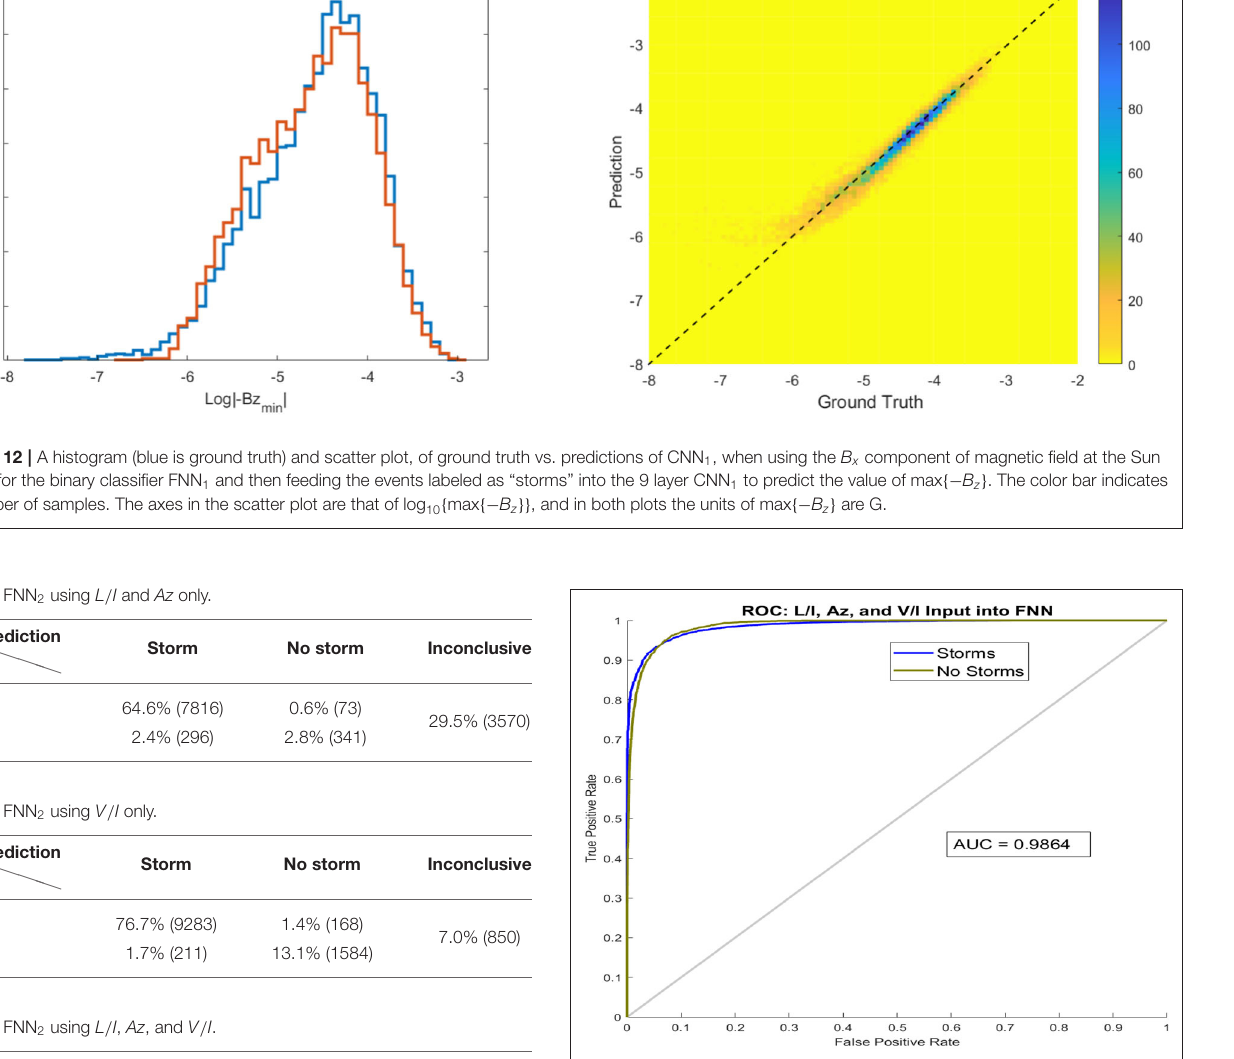
FIGURE 13 | The ROC (Receiver Operator Characteristic) curve for the binary classifier FNN 2 with all 3 Stokes components as input ( L / I , Az , V / I ). An AUC > 0.9 is considered